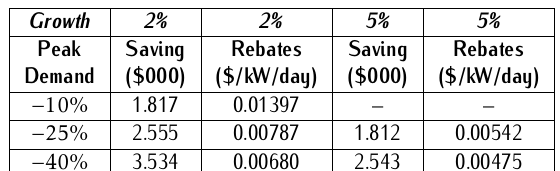
Table 8. Peak price rebates for controllable